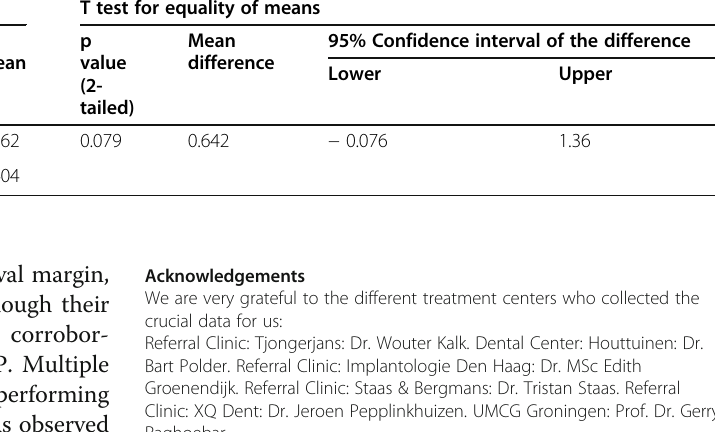
Table 3 Effect of biotype on pink aesthetic outcome 1 year post-operatively Group statistics T test for equality of